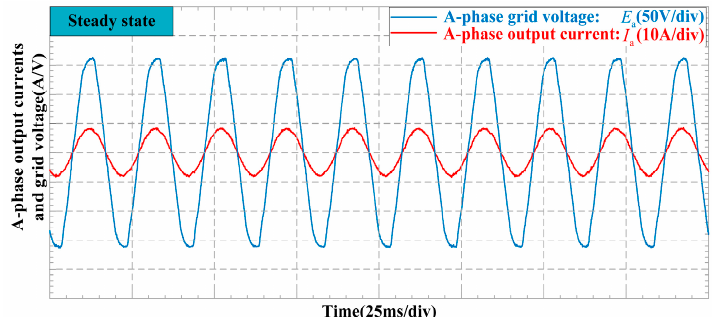
Figure 7. A-phase grid voltage and A-phase output current.